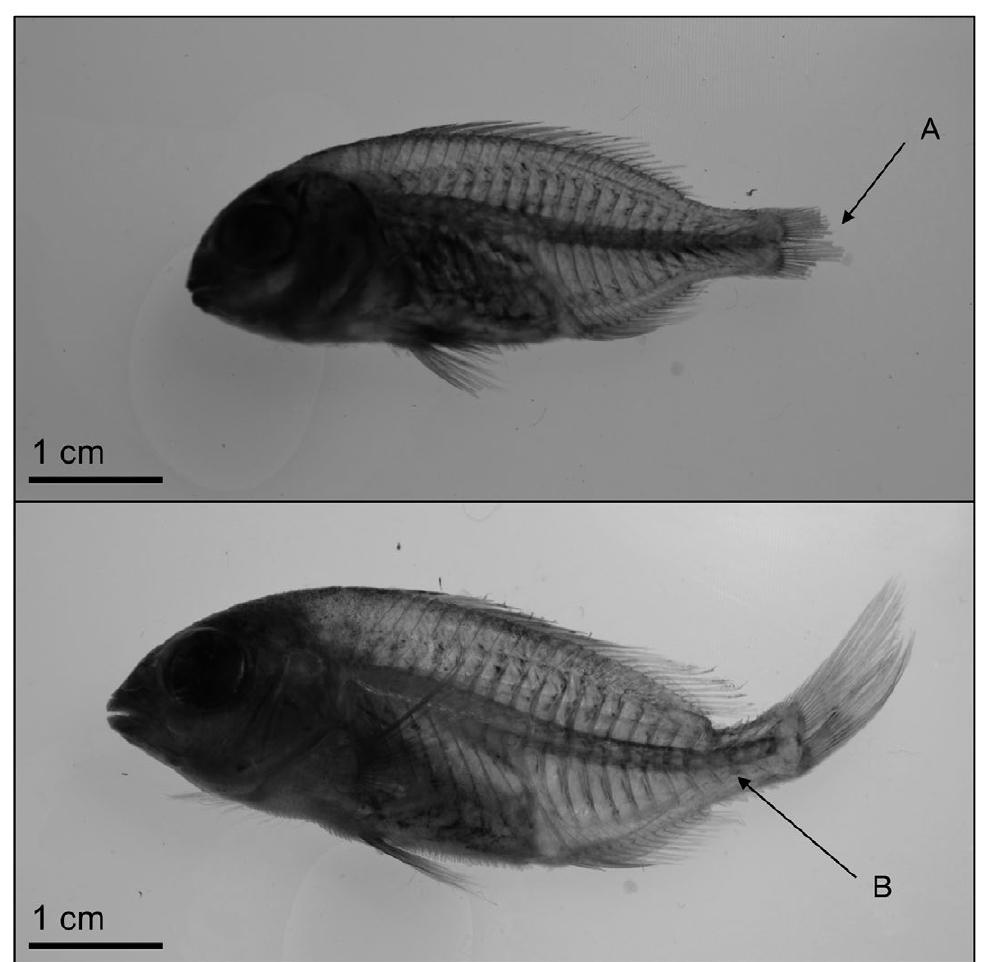
Fig. 2. – Cleared and stained skeletons of juvenile Rhabdosargus holubi indicating examples of caudal fin ray anomalies (A), and caudal vertebrae lordosis (B) in specimens from the Swartkops Estuary living in hypersaline conditions of 50 in aquaria for 10